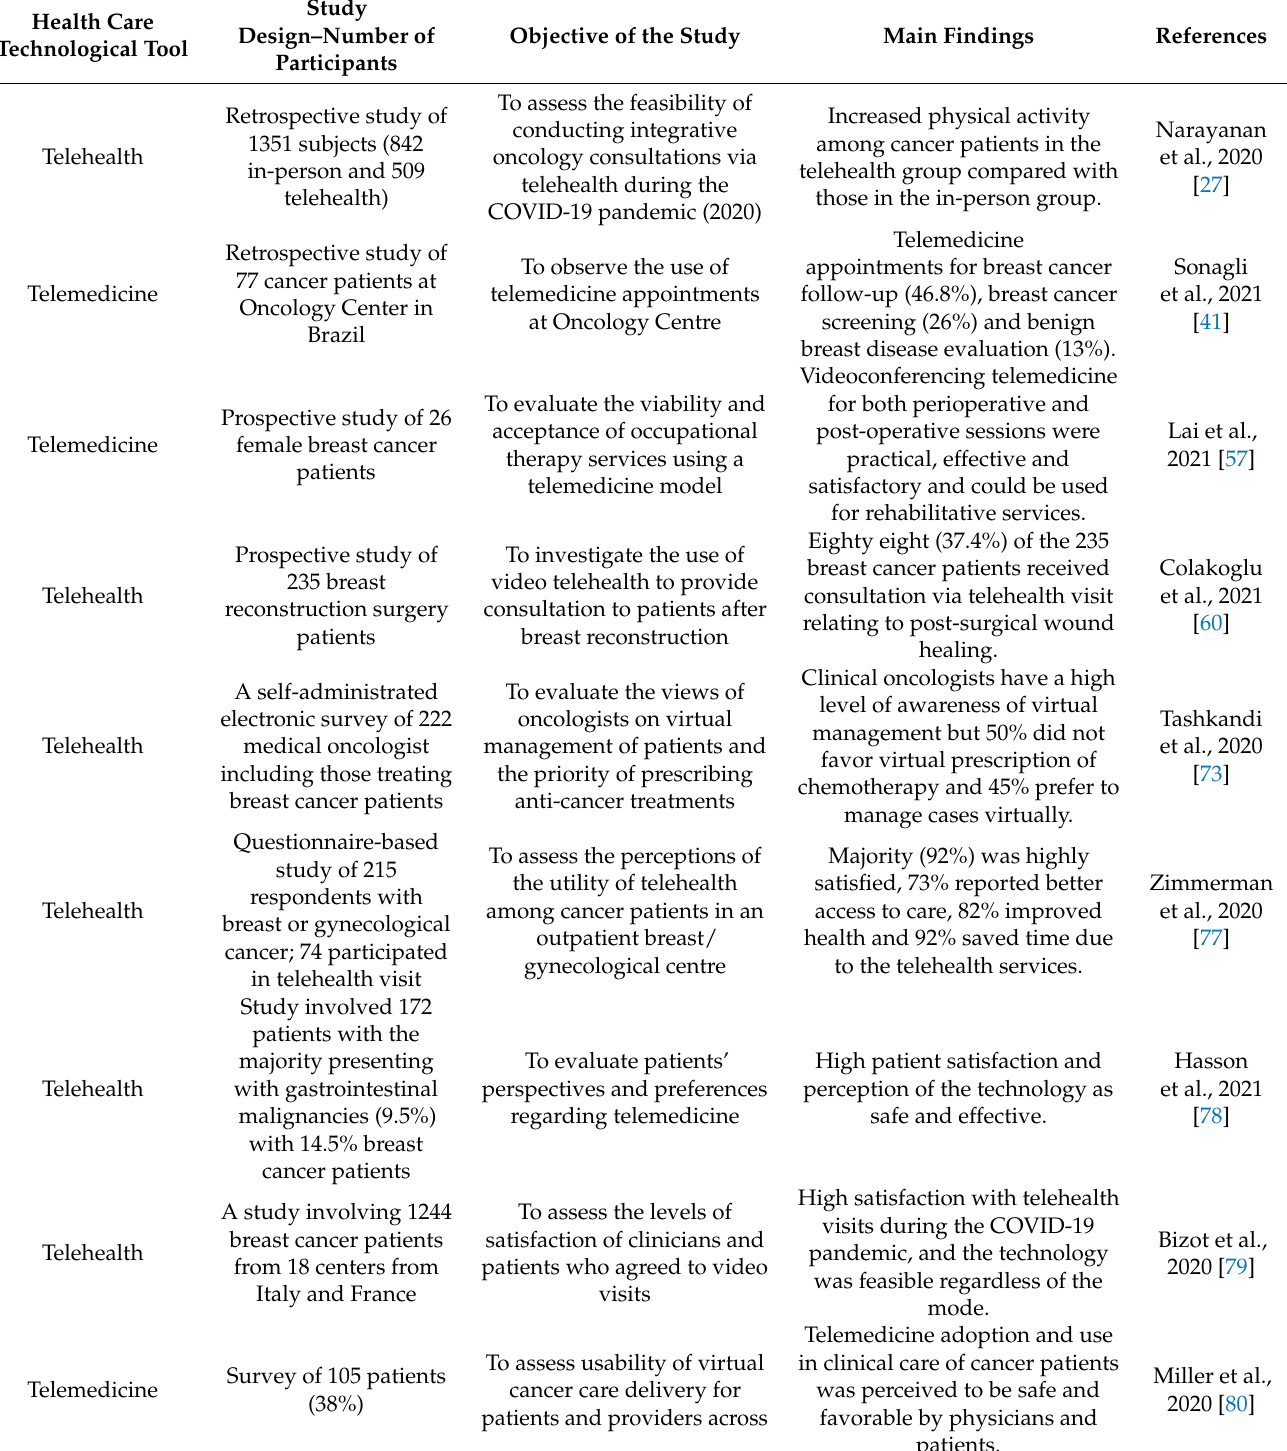
Table 1. The utilization and benefits of telehealth and telemedicine to breast cancer patients during the COVID-19 pandemic. Health